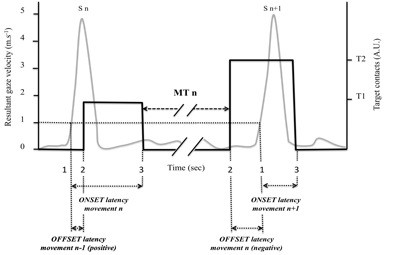
Illustration of the methodological approach to compute ONSET and OFFSET latencies. The black line represents the contacts between the stylus and the targets. The grey line represents resultant gaze velocity in the vertical plane. Numerical marks are defined as follows: 1 = onset of gaze saccade; 2 = end of the preceding hand movement; 3 = onset of the considered hand movement. Note that OFFSET latency of the movement n-1 is positive (saccade n began before the end of movement n-1) whereas the OFFSET latency of the movement n is negative (saccade n + 1 began after the end of movement n). It can also be observed that ONSET latency for movement n is longer than ONSET latency for movement n + 1.